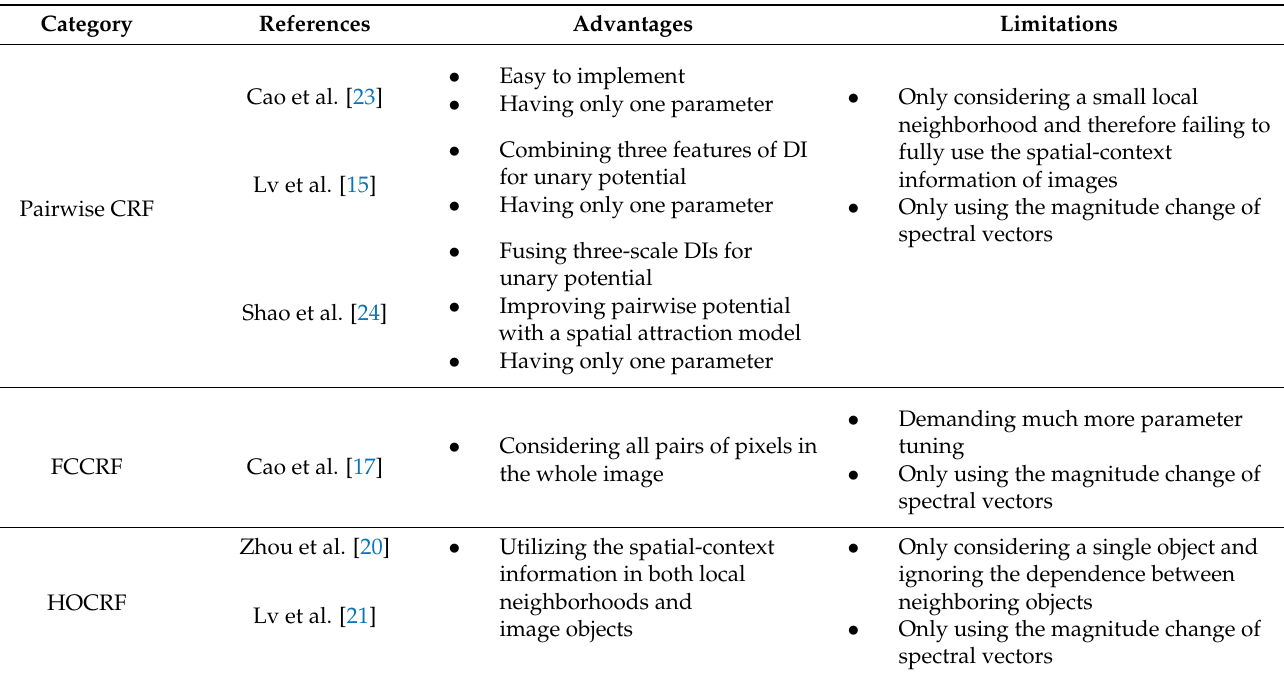
Table 1. The comparison of unsupervised CD methods based on